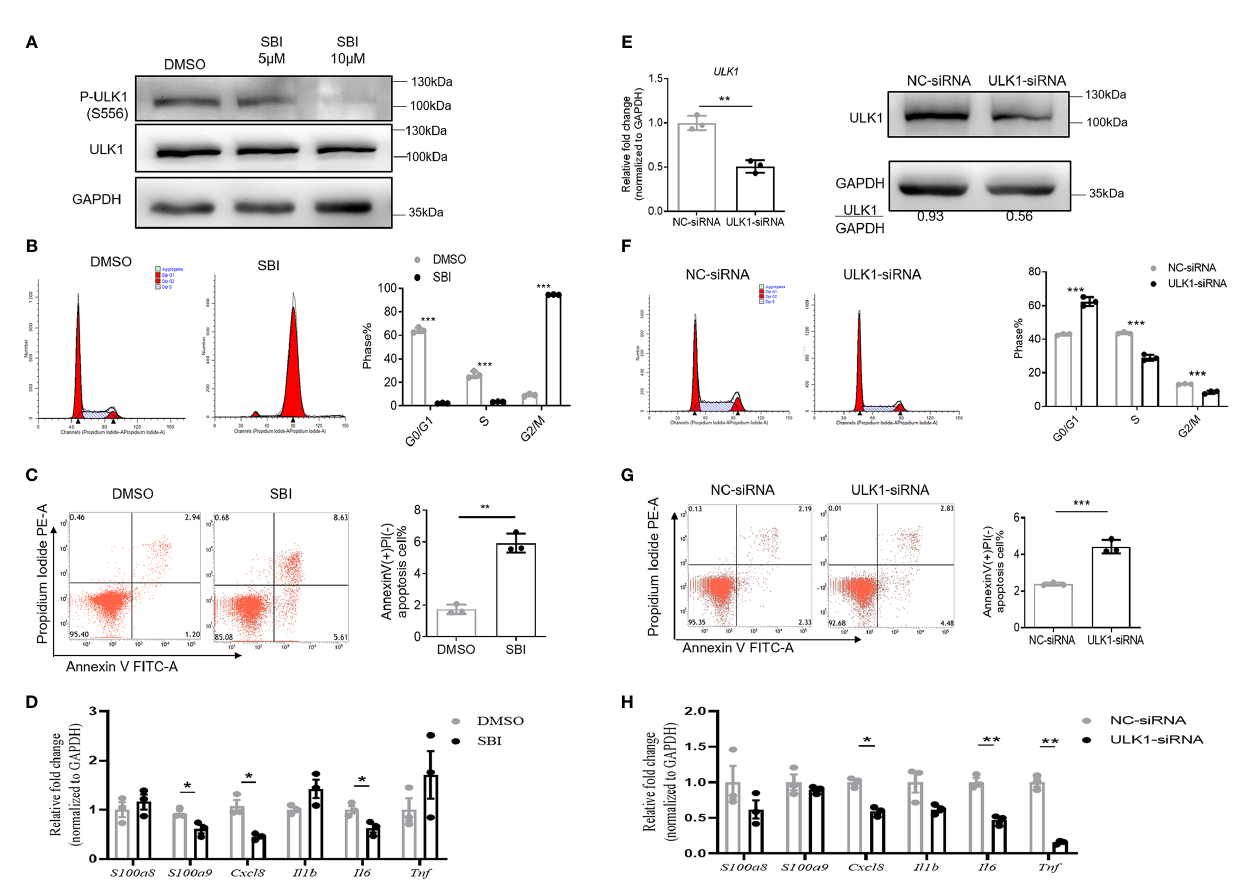
FIGURE 4 | Inhibition of ULK1 suppresses proliferation and promotes apoptosis of keratinocytes in vitro . (A) Immunoblot of HaCat keratinocytes 24 hours after cocultured with DMSO, 5 µM or 10 µM SBI-0206965 (SBI). (B) Cell cycle analysis of HaCat keratinocytes treated with DMSO or 10 µM SBI for 24 hours. The bar graph shows the percentage of cell population in each phase of cell cycle. (C) Apoptosis of HaCat keratinocytes 24 hours after serum deprivation in the presence of DMSO or 10 µM SBI. (D) mRNA expression of psoriasis-related in fl ammatory mediators in HaCat keratinocytes cocultured with DMSO or 10 µM SBI for 24 hours. (E) mRNA and protein expression of ULK1 in HaCat keratinocytes transfected with negative control-siRNA(NC-siRNA) and ULK1-siRNA. (F) Cell cycle analysis of HaCat keratinocytes 72 hours after transfection with NC-siRNA or ULK1-siRNA. (G) Apoptosis of transfected HaCat keratinocytes 24 hours after serum deprivation. (H) mRNA expression of psoriasis-related in fl ammatory mediators in HaCat keratinocytes transfected with NC-siRNA or ULK1-siRNA for 72 hours. Data are presented as mean ± SEM. *p < 0.05; **p < 0.01; ***p <